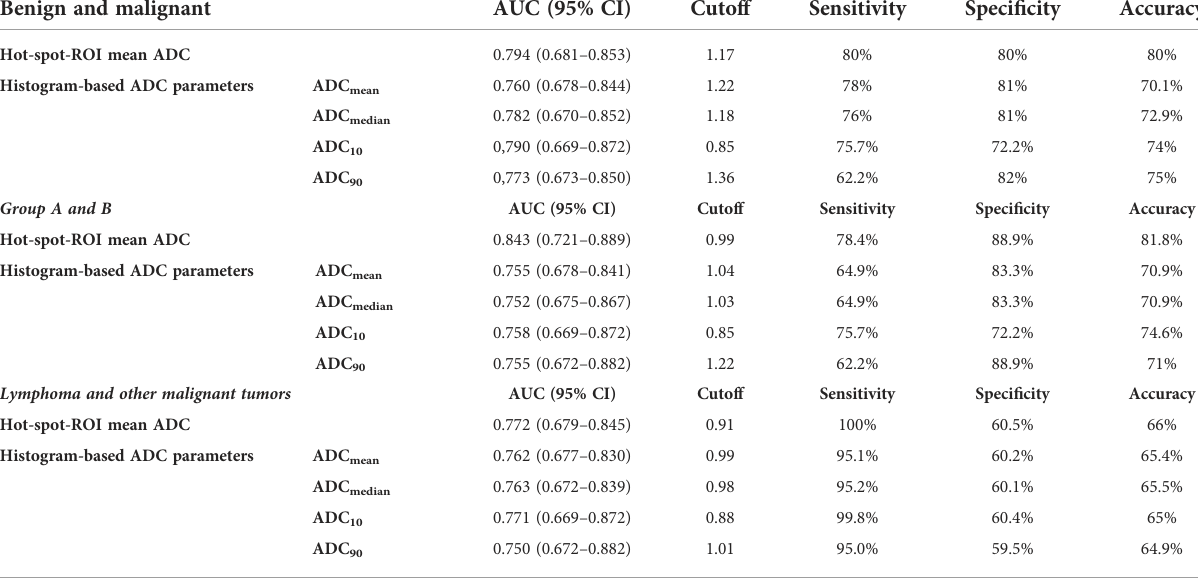
CI, con fi dence interval. All cutoffs were selected as the points achieving the maximal Youden index. Bold and italics values indicated the values of the two main groups (benign lesions and malignant lesions). microscopic fat components; the low average SIIs of these lesions in our study correlated well with that fact. The low SII of malignant tumors in our study was similar to the result of M.